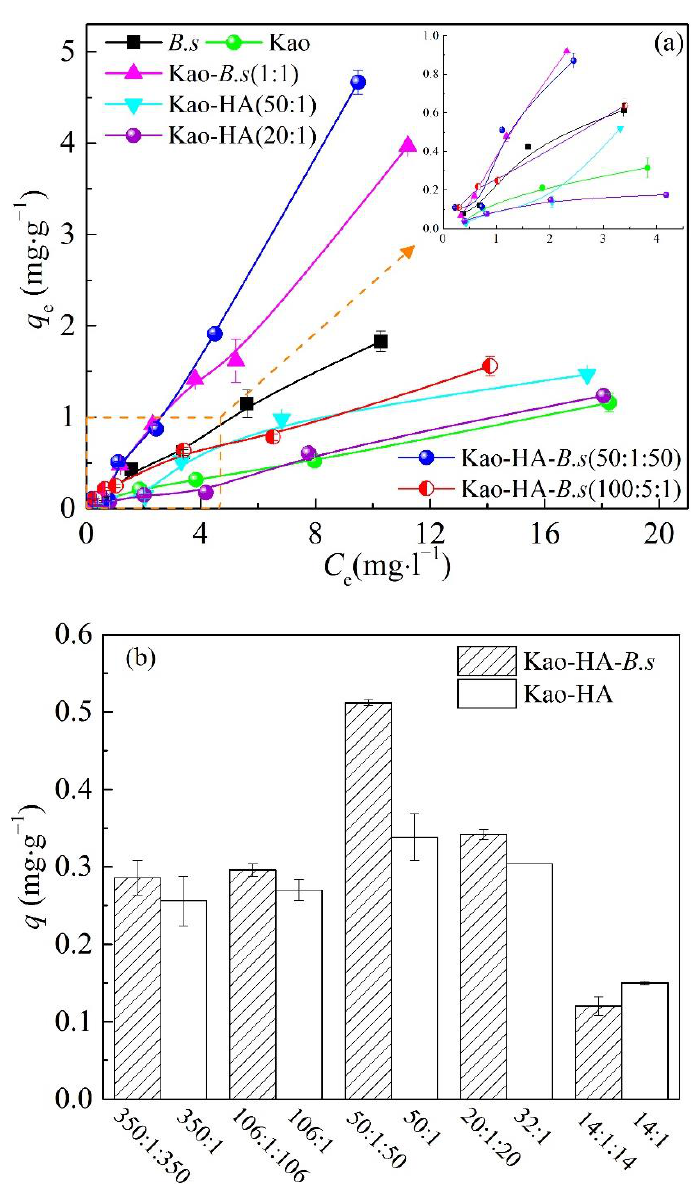
Figure 3. Effect of composite types on As(V) adsorption on Kao- B.s and Kao-HA- B.s (( a ) C 0 : 0.5–21.15 mg · L − 1 ; ( b ) C 0 : 2.5 mg · L − 1 ; adsorbent dosage: 2.5 mg · L − 1 ; T: 25 ◦ C; ionic strength: 0.01 mol · L − 1 ; t: 24 h).